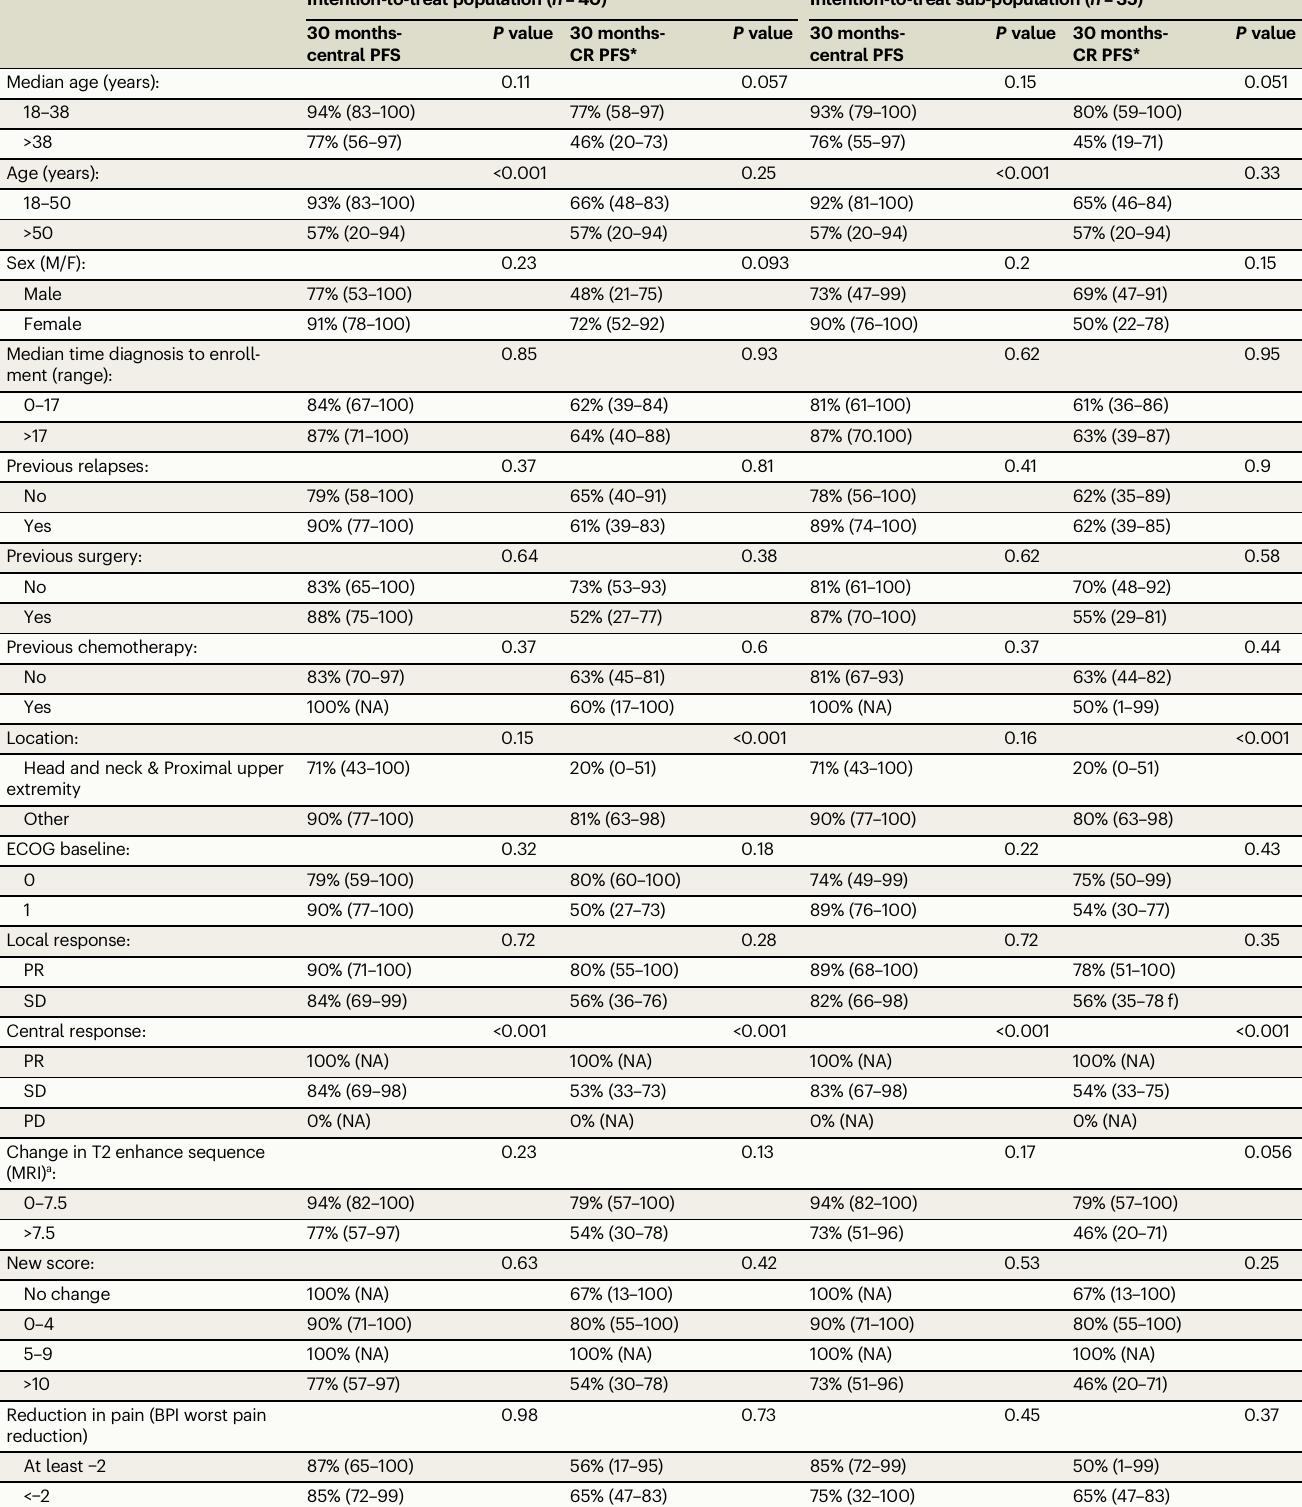
Table 3 | Univariate progression-free survival